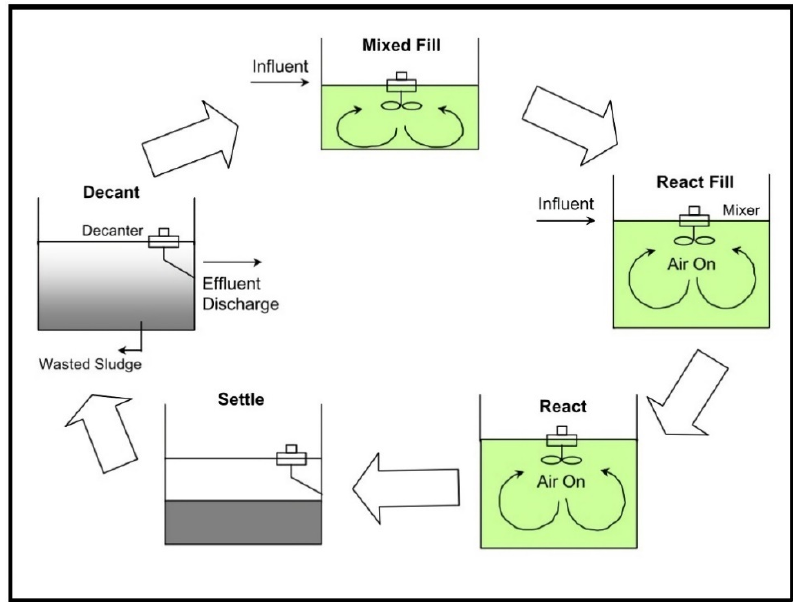
Figure 4. Schematic of the sequencing batch reactor (SBR) processing cycle. Adapted from Ref. [23].